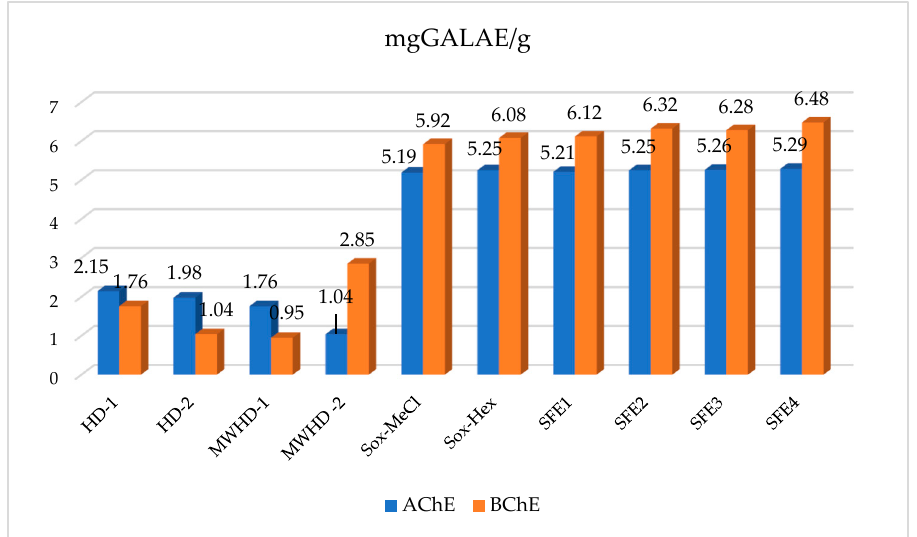
Figure 5. Inhibition of acetylcholinesterase (AChE) and butyrylcholinesterase (BChE) by chamomile extracts obtained by various extraction and distillation techniques.